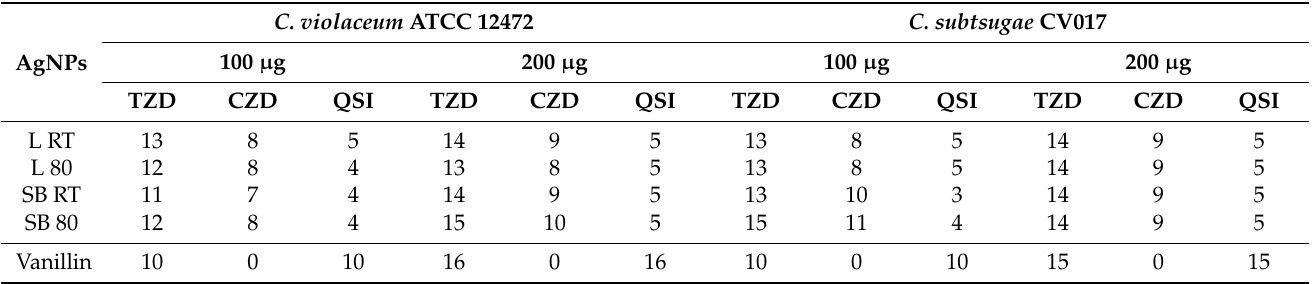
synthesized at 80 ◦ C; SB RT: Stem bark AgNPs synthesized at room temperature. SB 80: Stem bark AgNPs